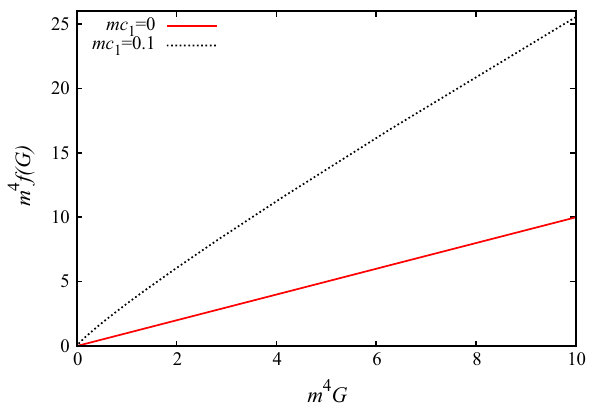
Fig. 1 Difference between the behavior of f ( G ) for mc 1 = 0 and mc 1 = 1, with q = 0 . 1 m , m 2 (cid:12) = 0 . 02 and c 0 =